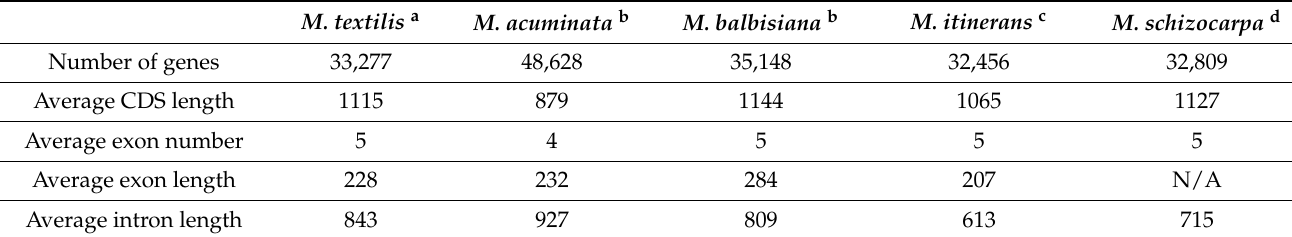
Table 2. Gene prediction results for sequenced M. textilis var. Abuab genome.